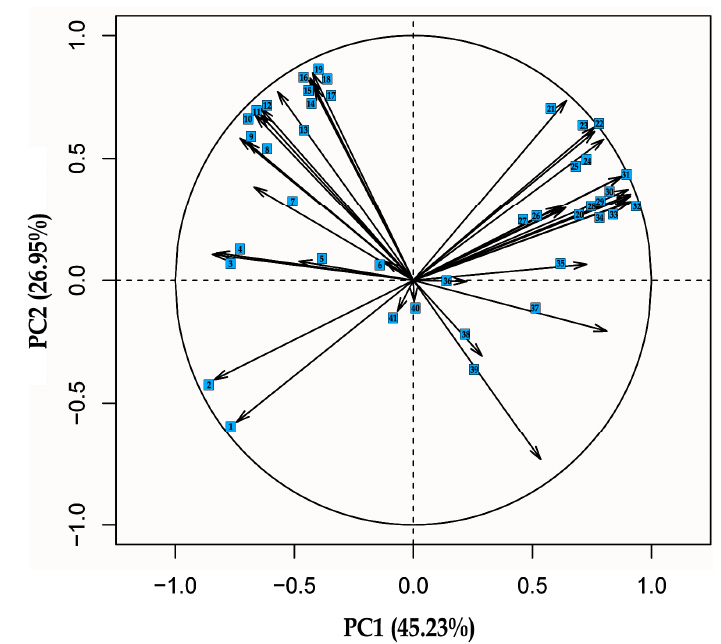
Figure 4. PCA of color features: 1—Saturation Mean, 2—Saturation Median, 3—R Std, 4—Saturation Std, 5—Cb Max, 6—HSV Hue, 7—Cb Std, 8—Brightness Std, 9—Luminance Std, 10—Cr Std, 11—Y